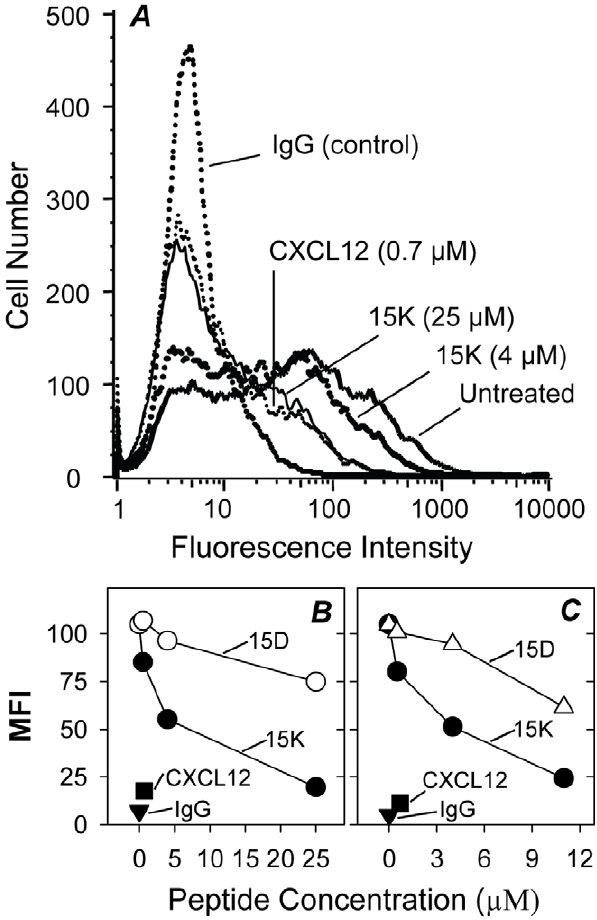
Figure 3. Effect of peptides 15K, 15D and scrambled peptide 15KS on the binding of anti-CXCR4 antibody 12G5 to CEMx174 cells. A. Dose-dependent effect of peptide 15K in comparison with CXCL12. B. The comparison of the effects of 15K and 15D. C. The comparison of the effects of 15K and 15KS. Cells were preincubated at 22 u C with peptides at designated concentrations or CXCL12 for 60 min. Then cells were incubated with FITC-labeled anti-human CXCR4 monoclonal antibodies 12G5 for 40 min at 22 u C and washed with FACS buffer prior to flow cytometry.